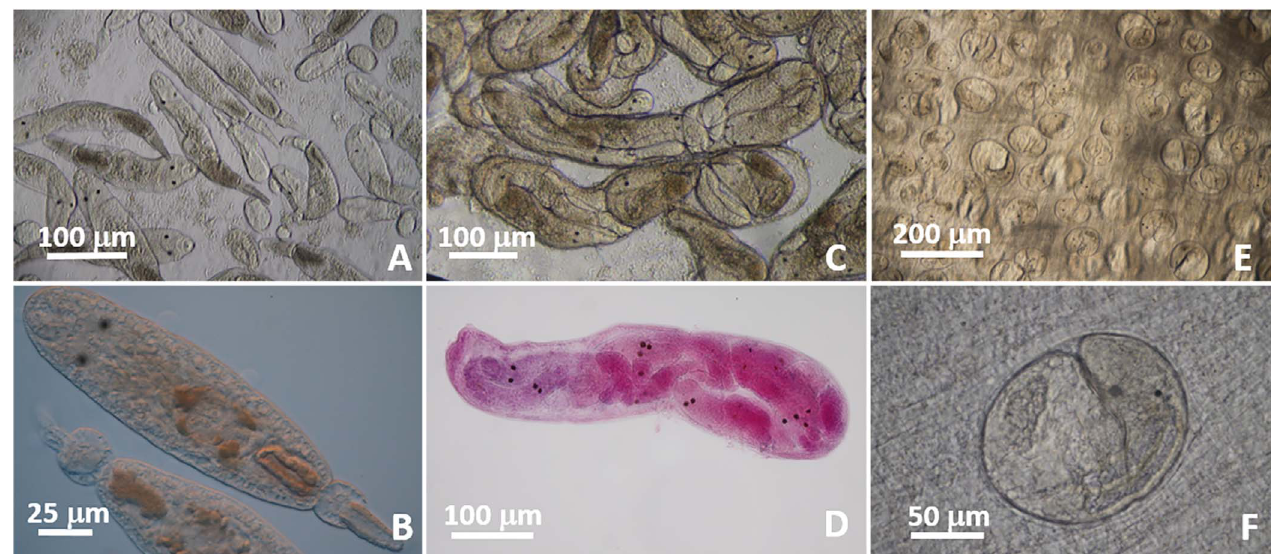
Figure 4. Lasiotocus choanura n. comb. in coquina Donax spp. (A – B) Live, unstained cercaria bi-ocellate, distome, with collar-like tail in D. fossor . (C – D) Sporocysts containing cercariae with conspicuous ocelli ((D) stained with acetocarmine). (E – F) Metacercariae, sometimes in high density (E) showing conspicuous ocelli, in situ in foot of coquina D. variabilis